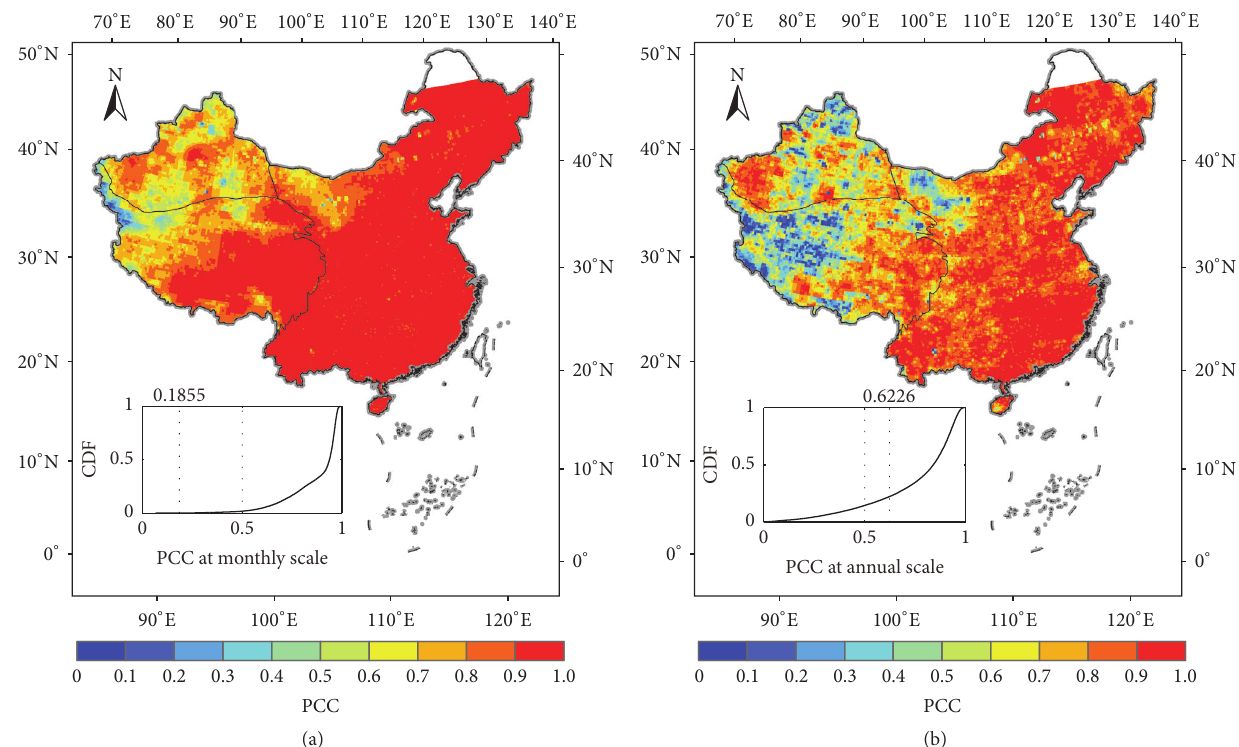
Figure 3: Distribution of PCCs between grid gauge precipitation and TRMM precipitation at monthly and annual scales over